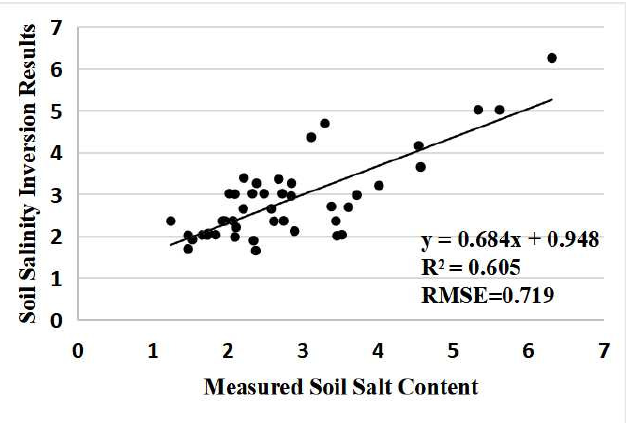
Figure 11. Scatter plots of soil salinity inversion results and measured salinity of corn in 2019.